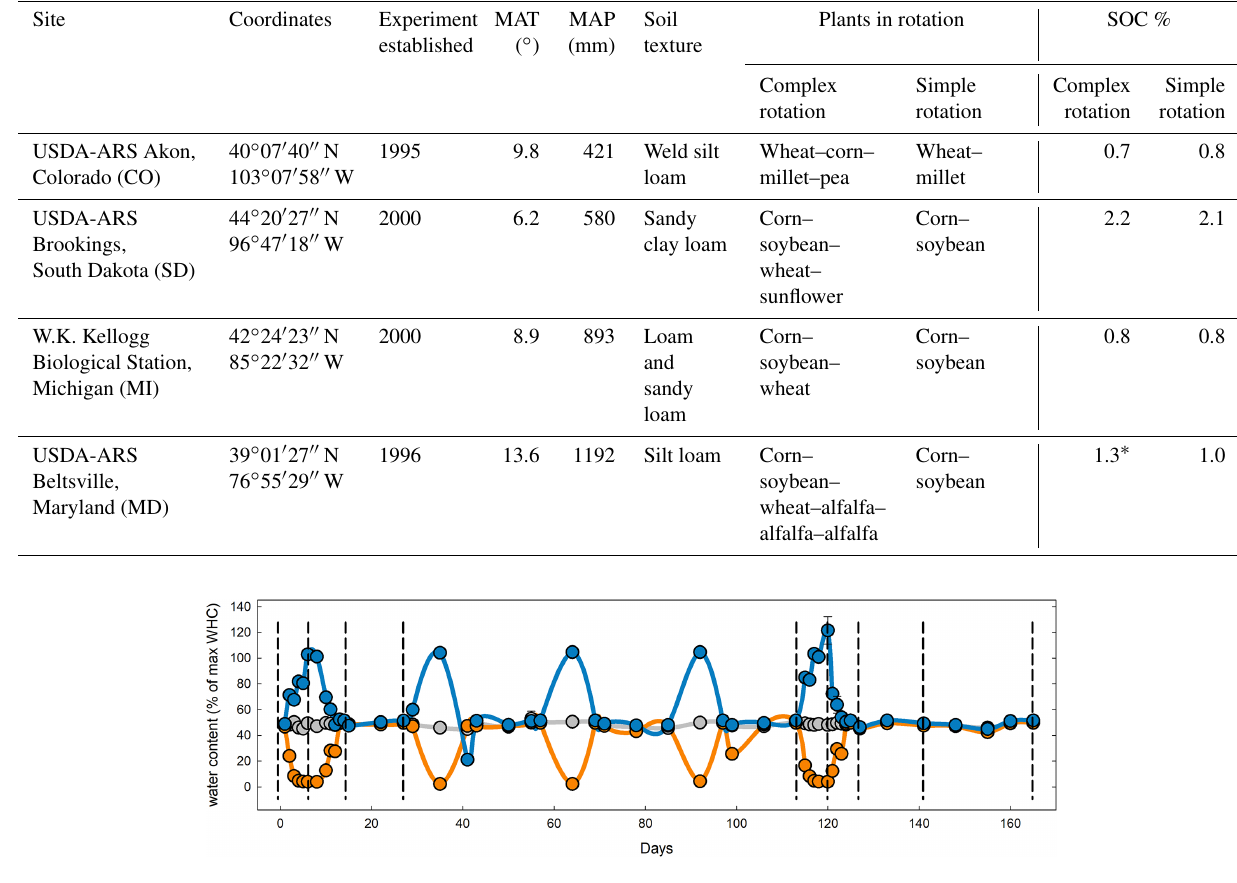
Figure 1. Mean water holding capacity of all four sites and rotation lengths during the course of the experiment. Symbols and lines in blue represent the flooding treatment; orange, the drought treatment; and gray, the control. Dashed vertical lines represent destructive harvests (1–4 and 6–10) of subsets on days 6, 14, 27, 113, 120, 127, 141, and 165. To study long-term recovery, an additional set of samples